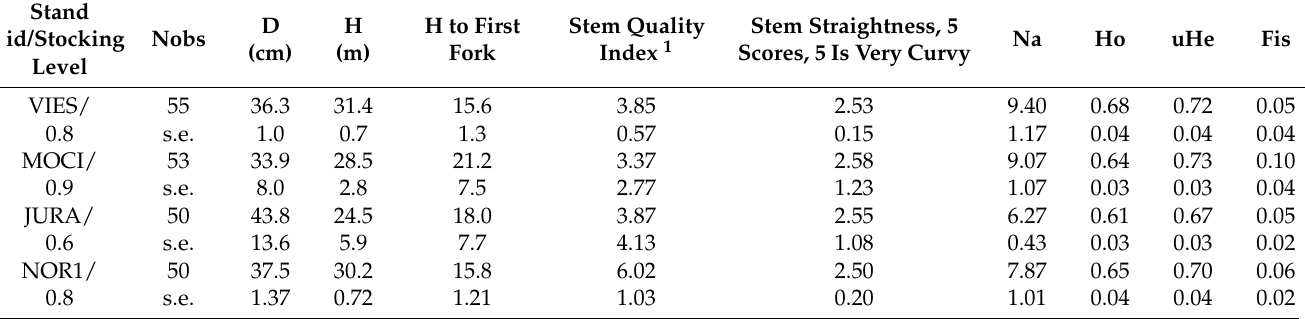
Table 2. Comparison of the morphology traits and within the within stand genetic diversity indexes among the studied stands of European beech. se. stands for standard error. Stocking level of the stands is given below the stand ids (stocking of 1 means complete crown closure). Nobs is sample size. Na is mean number of different alleles, Ho and He observed and expected heterozygotes, Fis inbreeding coefficient (s.e. for DNA data was calculated from individual locus